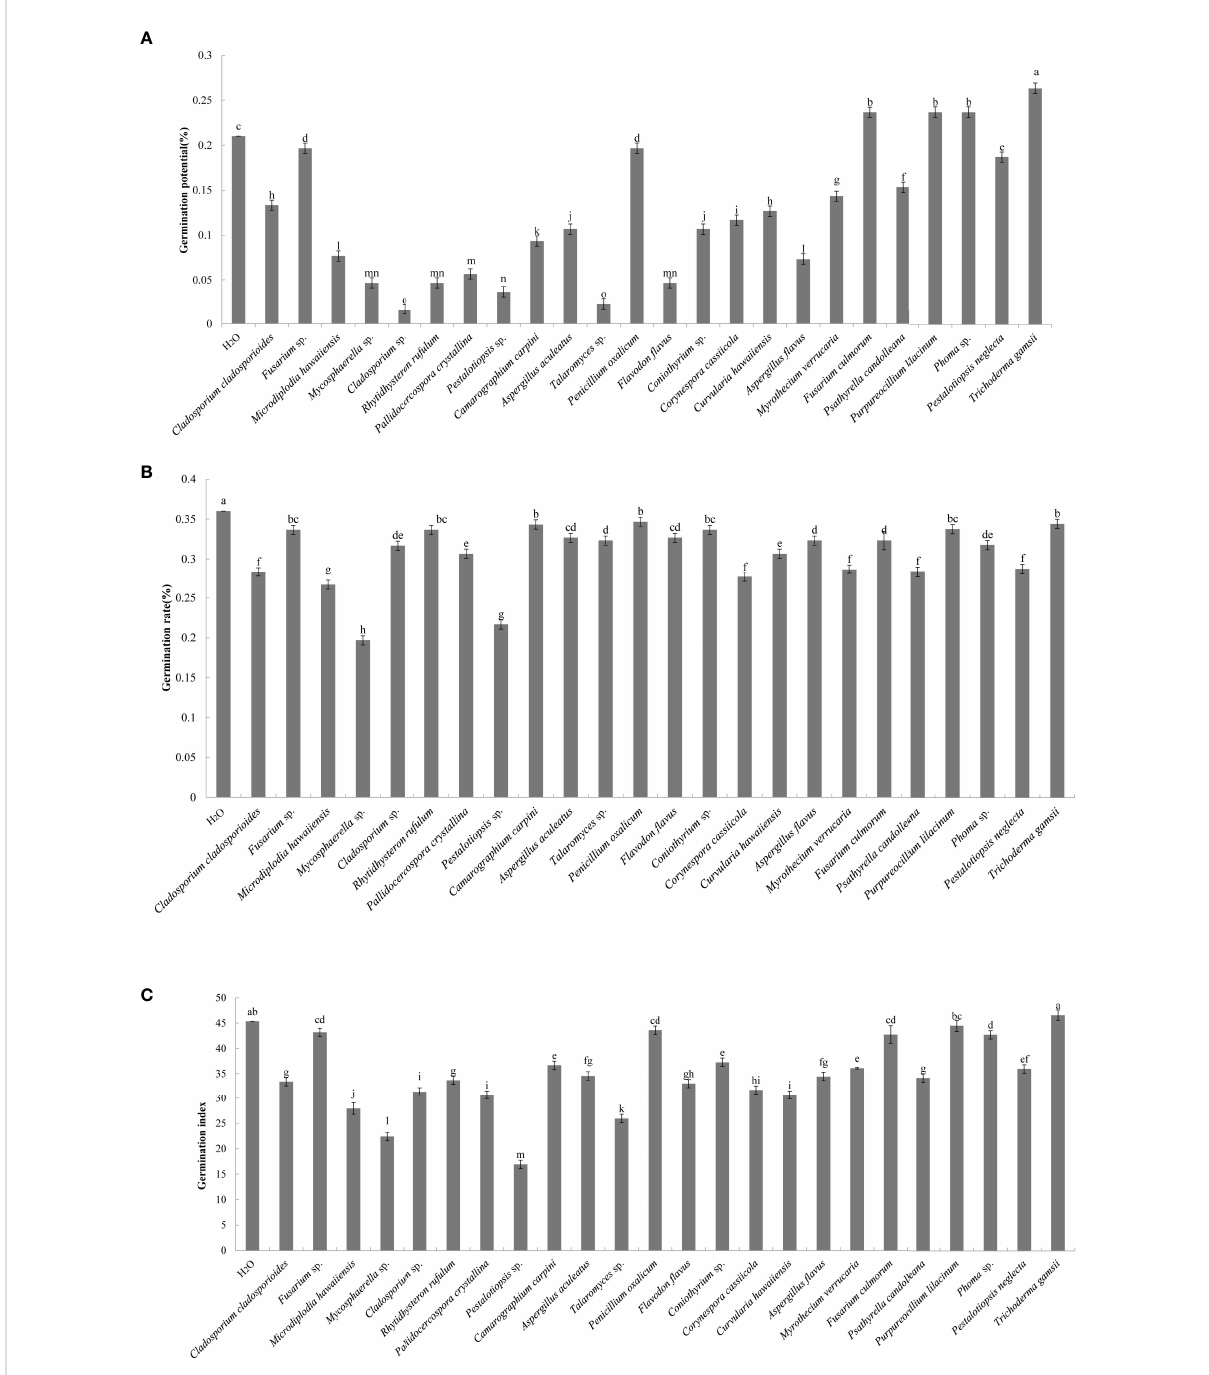
FIGURE 1 Effect of the 24 fungal strains on the germination of seeds of C. equisetifolia. Values marked with different letters are signi fi cantly different at p<0.05. (A) germination potential; (B) germination rate; (C) germination